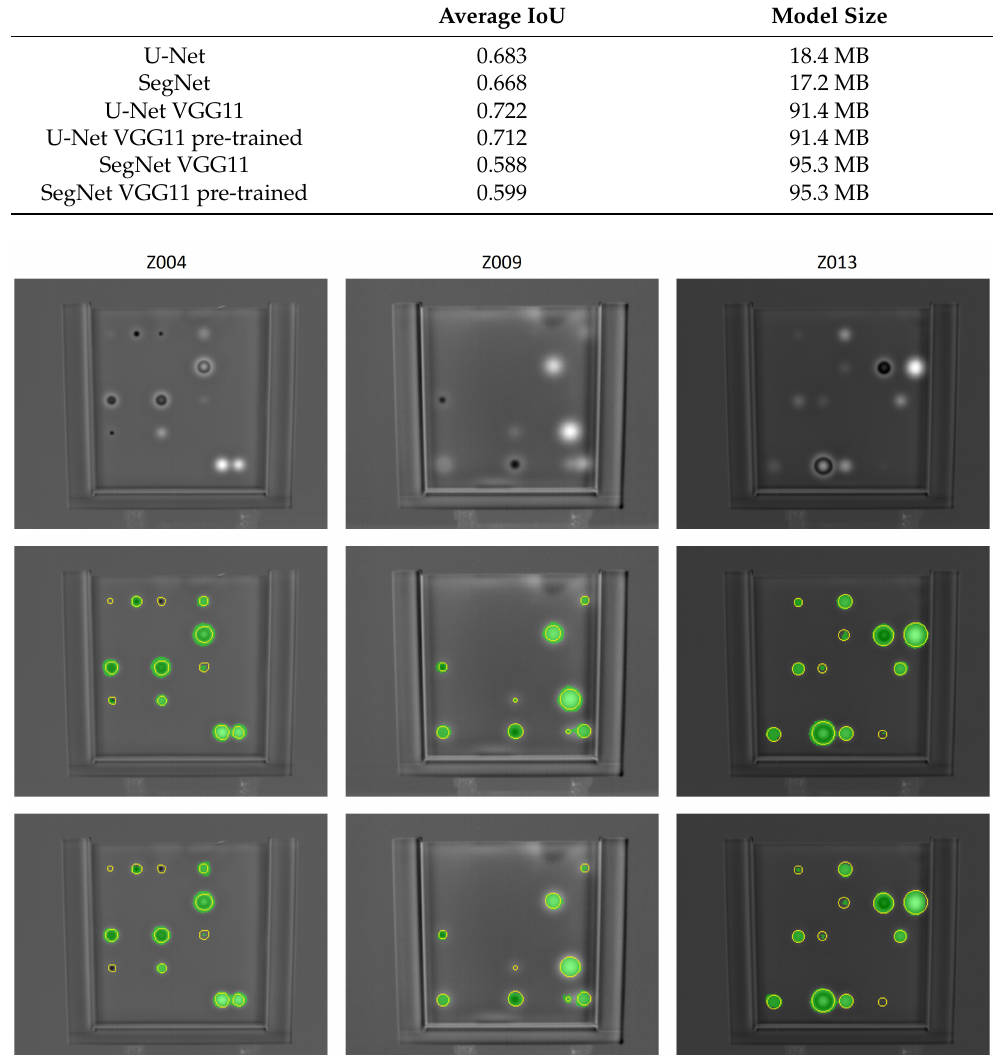
Figure 8. Visualization of segmentation results. The green masks represent the segmentations, and the yellow contours represent the ground truth areas. The first row shows PCT images of the PT measurements belonging to the test dataset. The second row displays the defect segmentation results obtained by applying SegNet on the original test dataset. The third row presents the corresponding results achieved by U-Net on the same test dataset of original